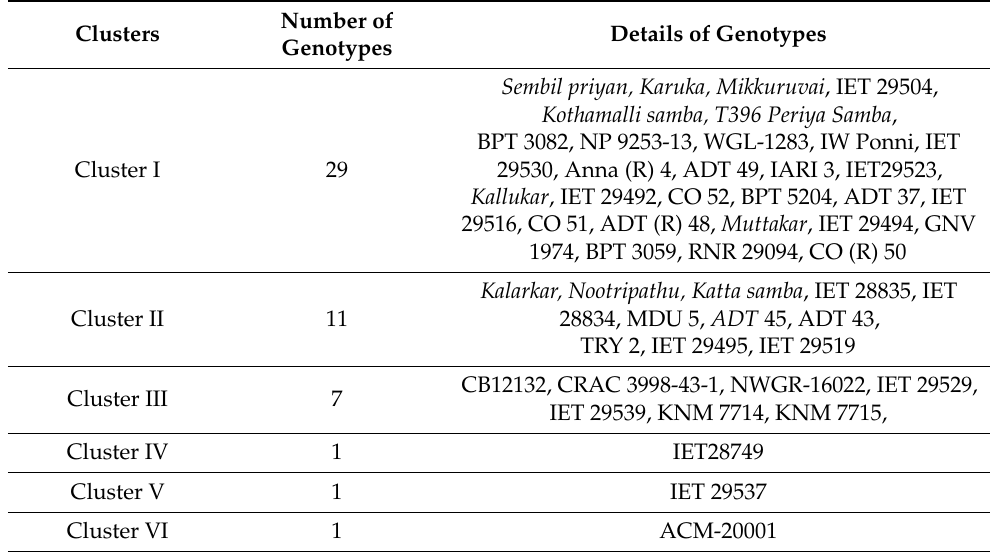
Table 2. Clustering of 50 rice genotypes for 14 panicle- and yield-related traits computed by Maha- lanobis’ D 2 analysis.